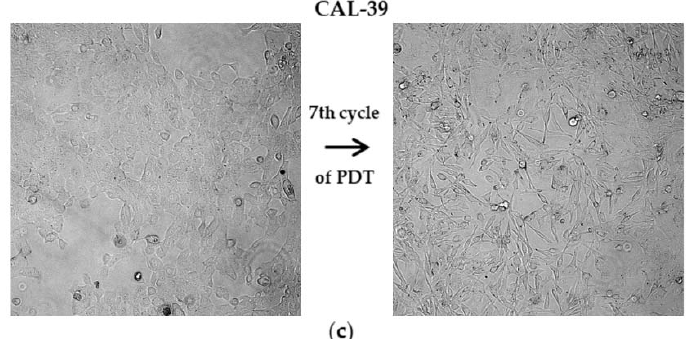
Figure 2. Cell survival in response to PDT. ( a ) Viability of A-431 parental cells that are sensitive to PDT (AS) and isolated resistant cells (AR) after PDT treatment. ( b ) Viability of CAL-39 parental cells, those sensitive to PDT (CS), and isolated resistant cells (CR). Cell survival was expressed as percentage of the non-treated control. Points represent average of at least three independent experiments. Asterisks indicate significant differences between the sensitive and resistant cells calculated by one-way ANOVA followed by the Bonferroni test (*** p ≤ 0.001). ( c ) Change in cell morphology after the 7th cycle of PDT in the CAL-39 cell line.